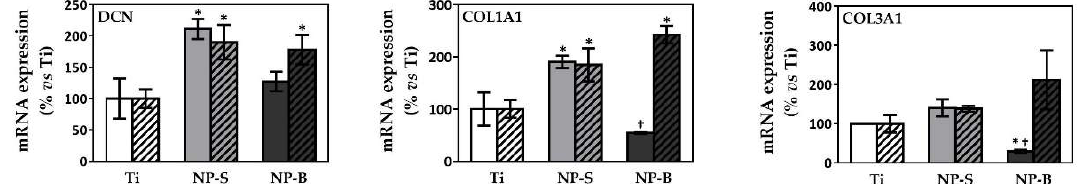
Figure 4. mRNA levels of gingival fibroblast differentiation markers after 14 d of cell culture. Plain bars correspond to donor hGF-A, and striped bars correspond to donor hGF-B. Data represents fold changes of target genes normalized to reference genes ( Gapdh and β-Actin ), expressed as percentage of control, which was set to 100%. Values represent the mean ± SEM ( n = 3) for each donor. Differences between groups were assessed by ANOVA and post-hoc LSD test: * p < 0.05 versus Ti; † p < 0.05 versus NP-S.